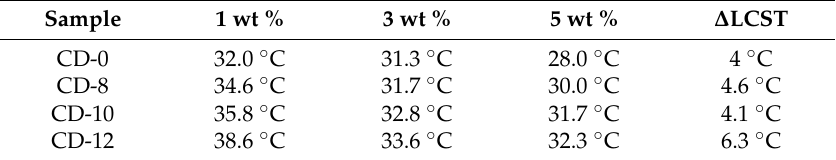
Table 2. Lower critical solution temperatures (LCSTs) of 1 wt %, 3 wt % and 5 wt % copolymer solutions.